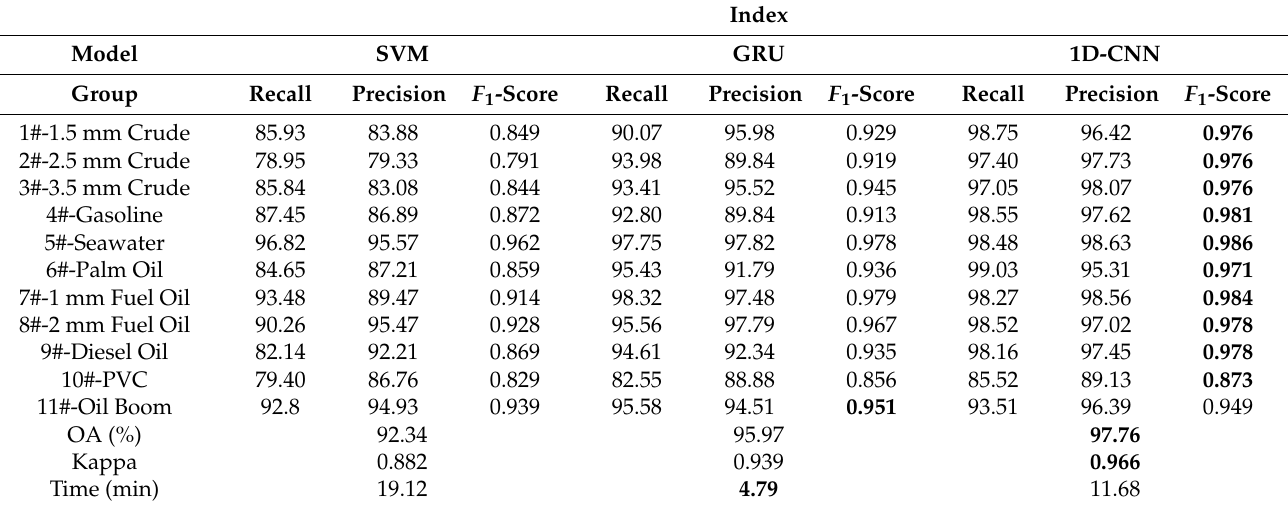
Table 5. Accuracy of the detection results at T1.